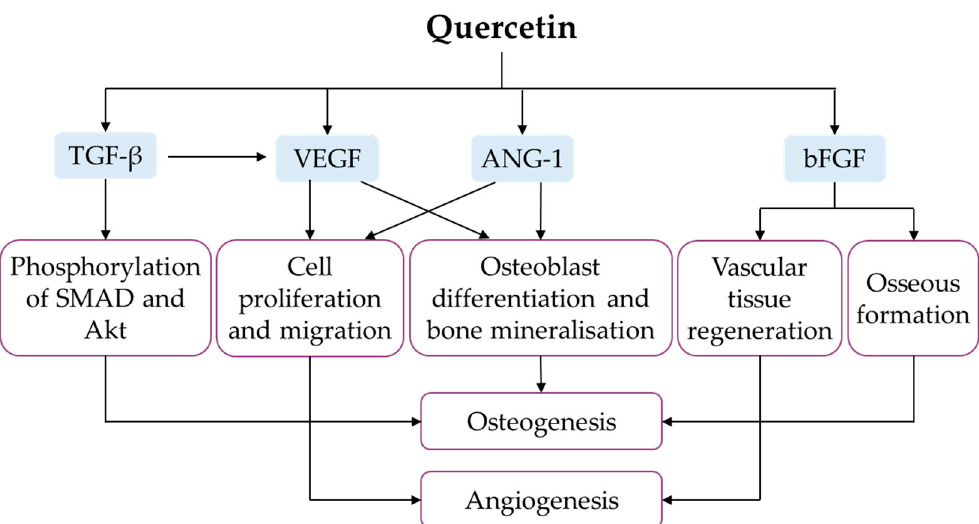
Figure 8. The effects of quercetin on the regulation of angiogenesis. Quercetin increases angiogenic factors (TGF- β , VEGF, ANG-1 and bFGF) to facilitate endothelial-cell proliferation and migration as well as vascular tissue regeneration. Additionally, these angiogenic factors play an important role in promoting osteogenesis. Abbreviations: Akt = protein kinase B; Ang-1 = angiogenin-1; bFGF = basic fibroblast growth factor; SMAD = Suppressor of mothers against decapentaplegic; TGF- β = transforming growth factor-beta; VEGF = vascular endothelial growth factor.